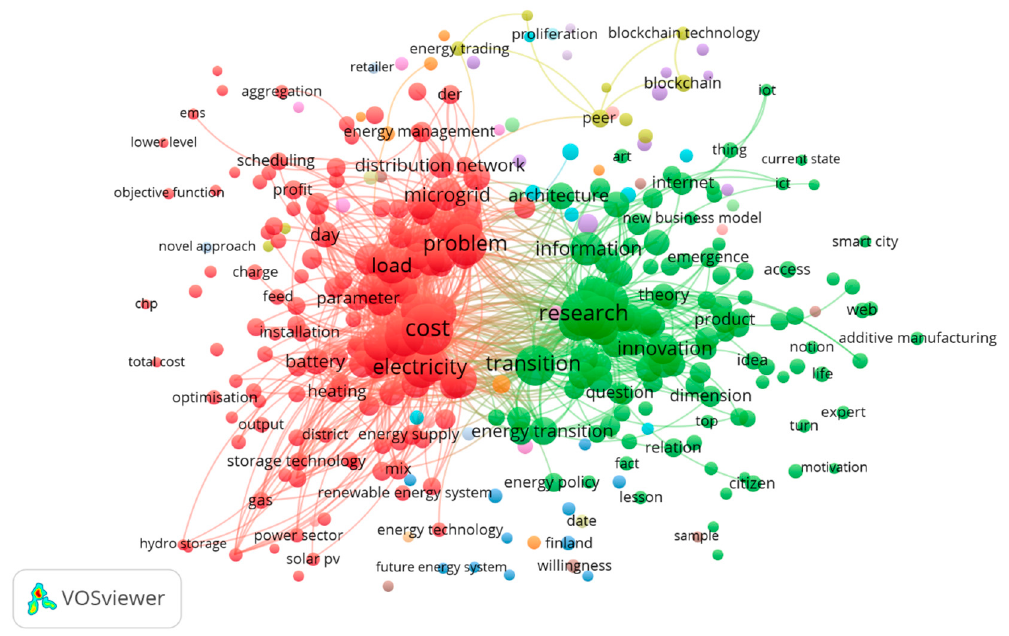
Figure 5. Connections between the abstracts through the full-counting analysis from VOSviewer.